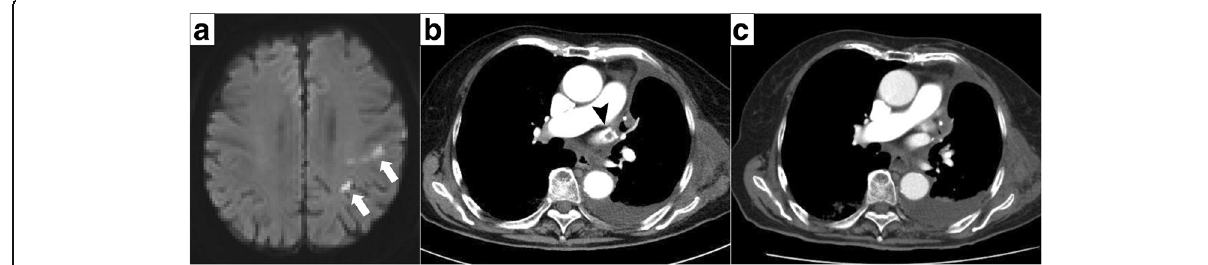
Fig. 3 a Diffusion-weighted magnetic resonance image (MRI) of the brain showing multiple high-intensity signals in the area of the left middle cerebral artery ( arrow ). b Contrast-enhanced chest CT after the first episode of cerebral infarction showing a thrombus in the left superior pulmonary vein stump measuring 10 mm in diameter ( arrow head ). c Thrombus in the left superior pulmonary vein stump disappeared on follow-up